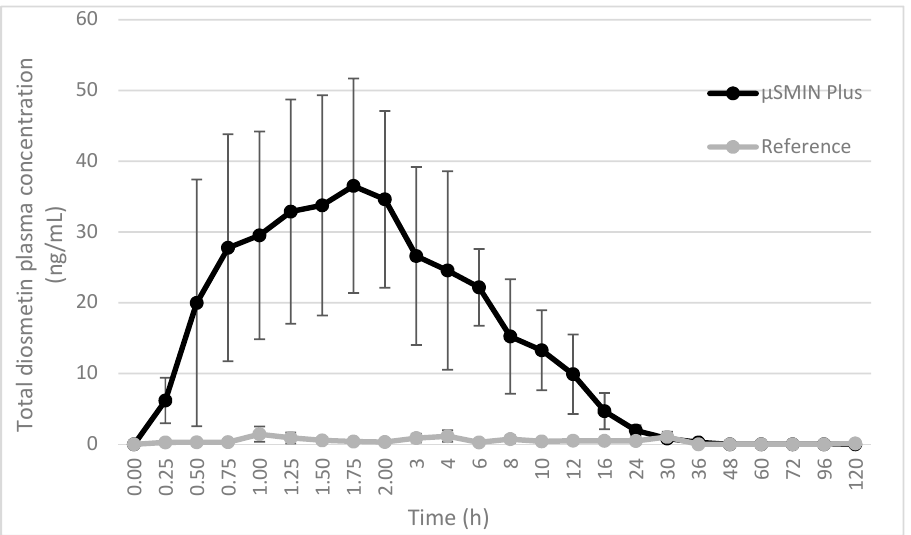
Figure 3. Plasma concentration time curves of diosmetin after a single oral administration of a tablet